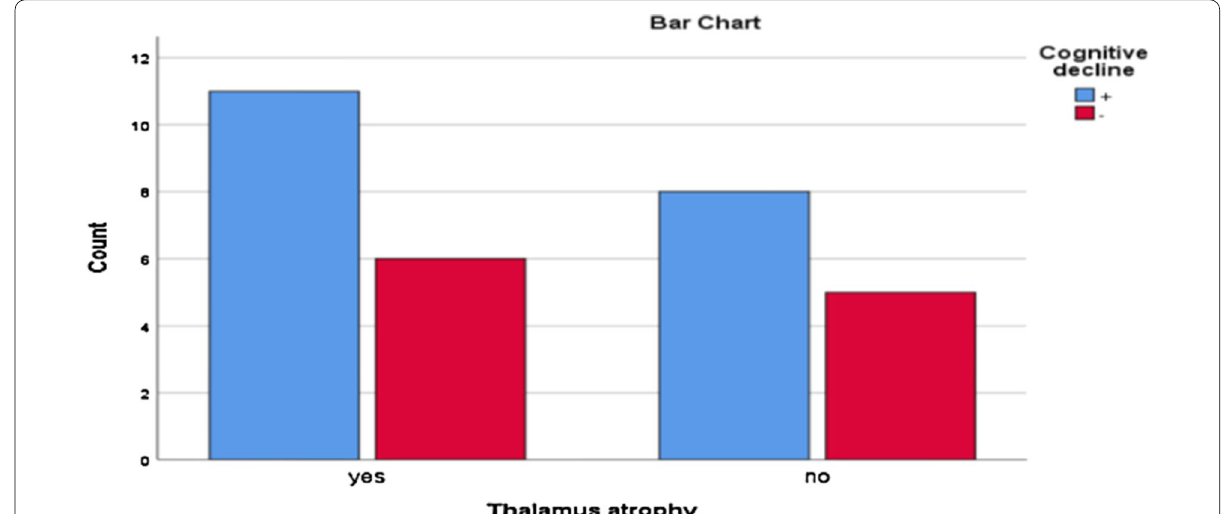
Fig. 17 Diagrammatic representation of number of patients with cognitive decline in patients with and without thalamic atrophy